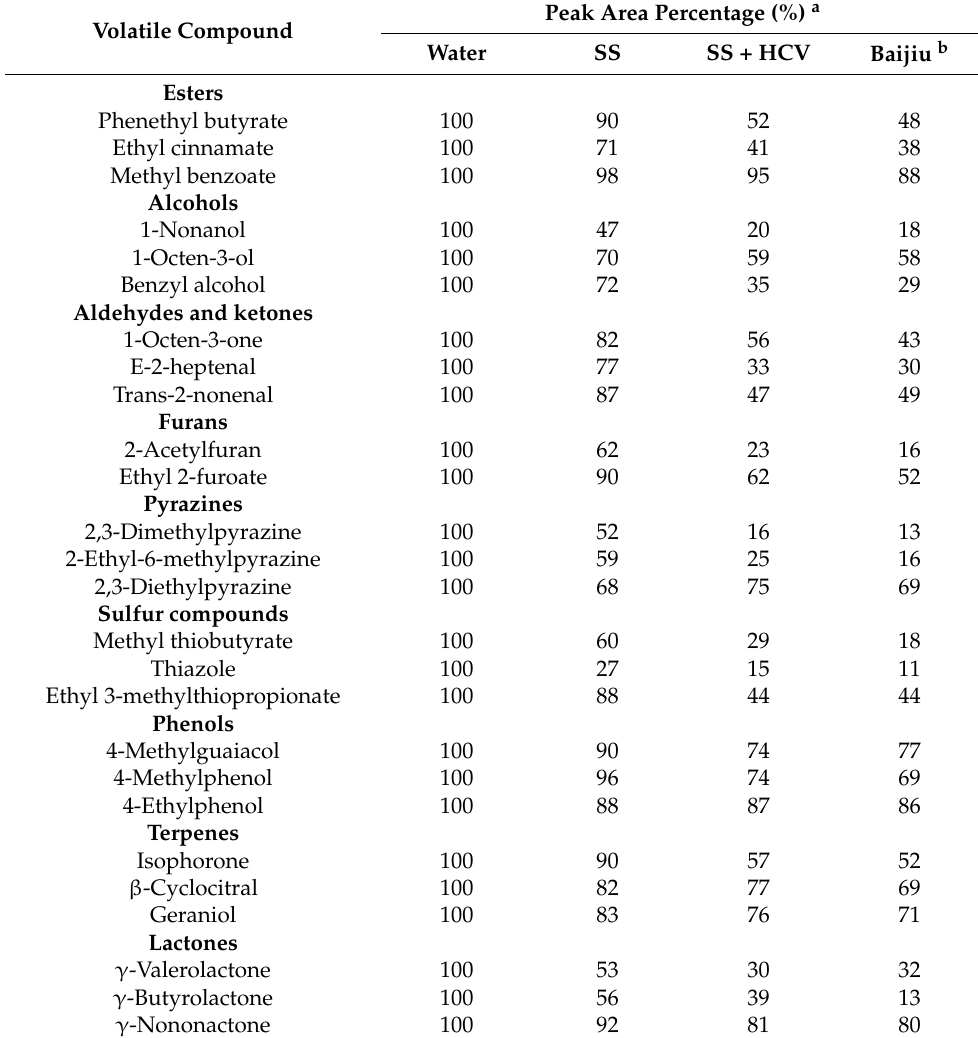
Table 1. Comparison of peak areas of volatile compositions in various